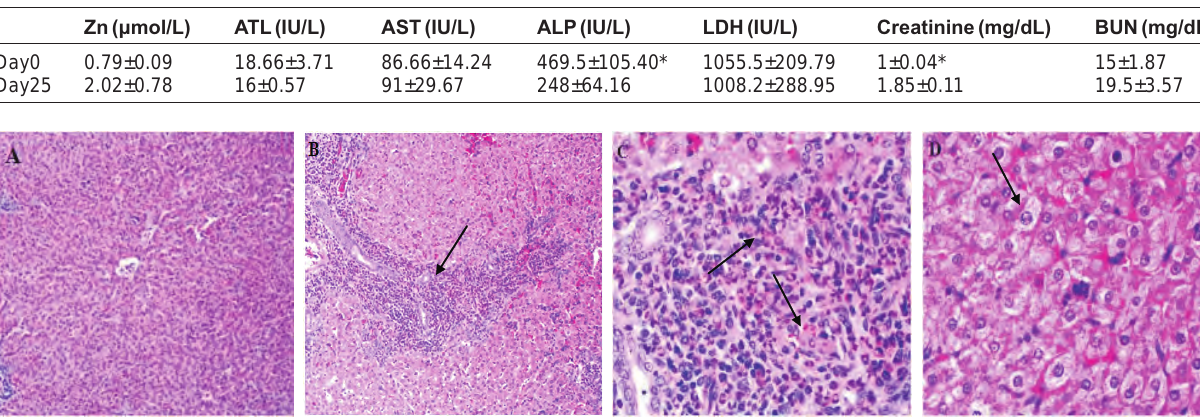
Sample: The size of the nano particle was determined Statistical analysis: SPSS version 16 (U.S.A.) was to be 25nm diameter by transmission electron microscopy.